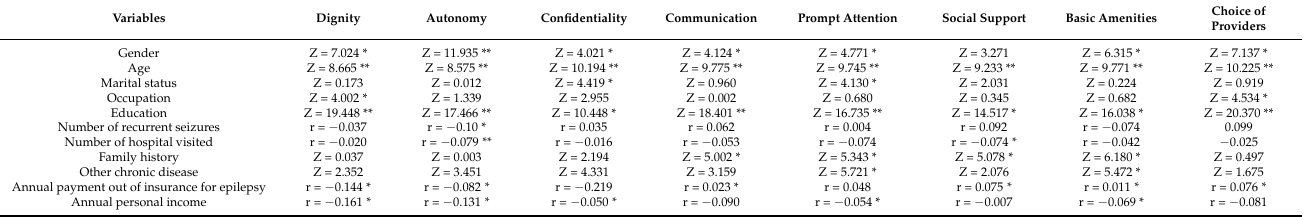
Table 5. Comparisons of patients-perceived HSR scores among different demographic